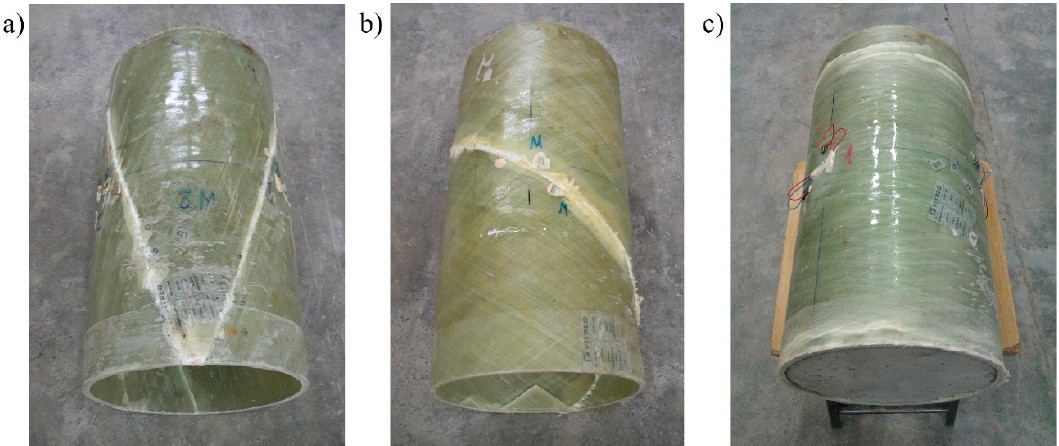
Figure 5. Test samples made of 40-cm-long hollow tube. View after destruction of elements with a fiber winding angle of: ( a ) 20°, ( b ) 55° and ( c ) 85°. Concrete plug visible in the last sample.